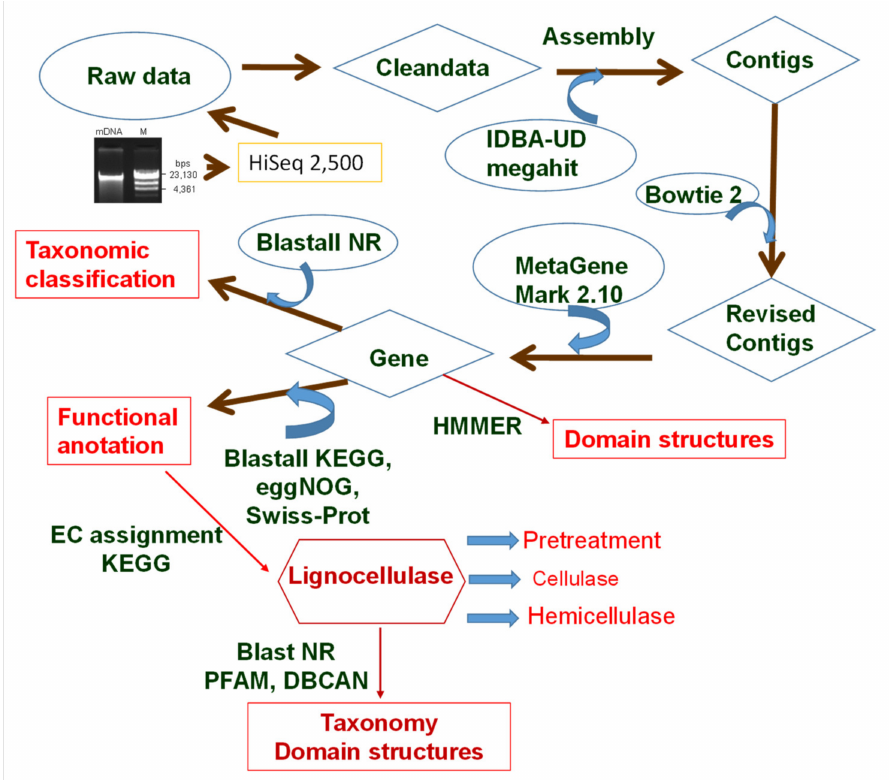
Figure 2. Workflow diagram for mining lignocellulose-degrading enzymes.